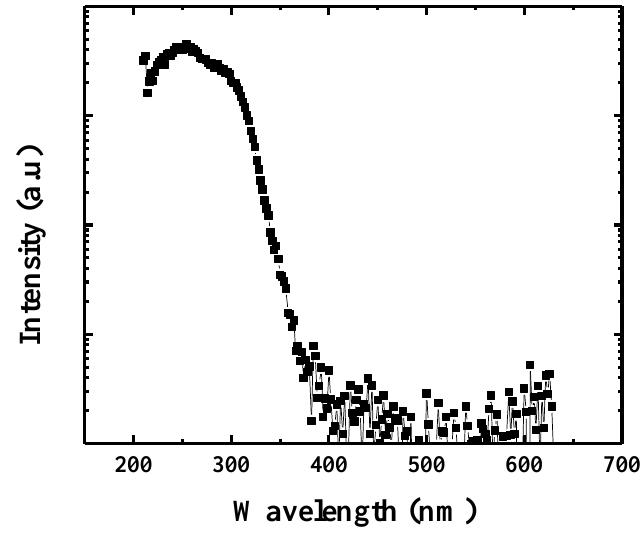
Figure 18. Typical photoresponse spectrum of SnO